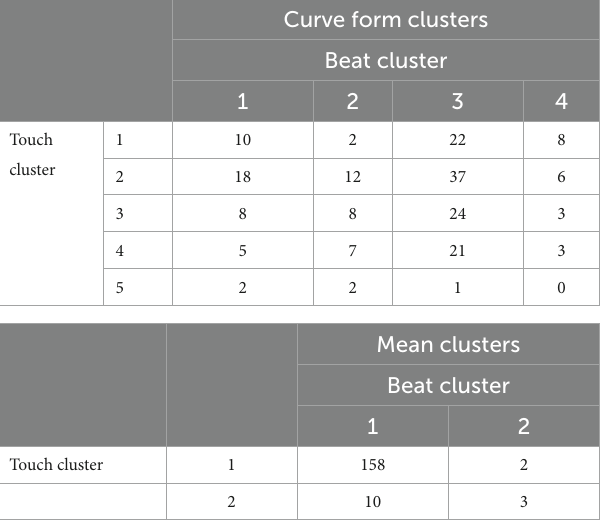
TABLE 1 Number of participants in one touch cluster that were in one and the same beat cluster. Curve form